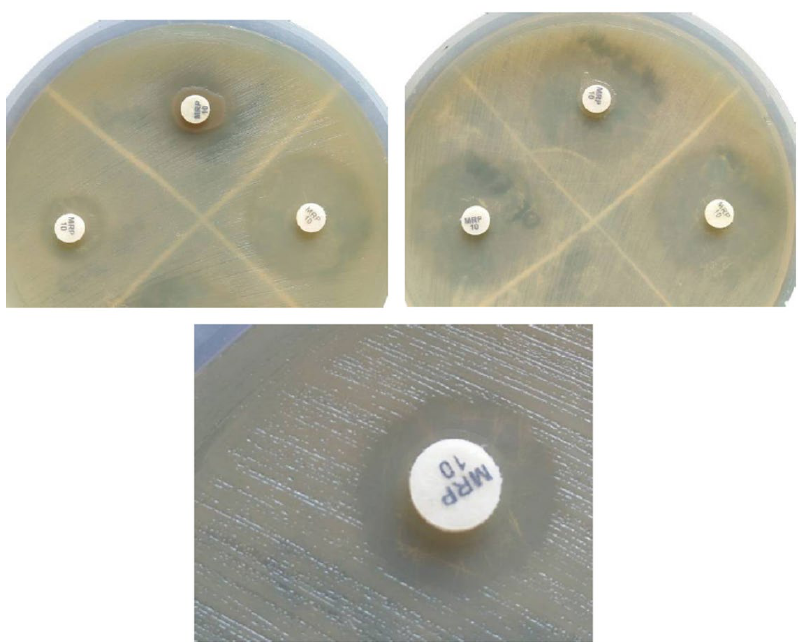
Fig. 1. Modified Carbapenemase Inactivation Method